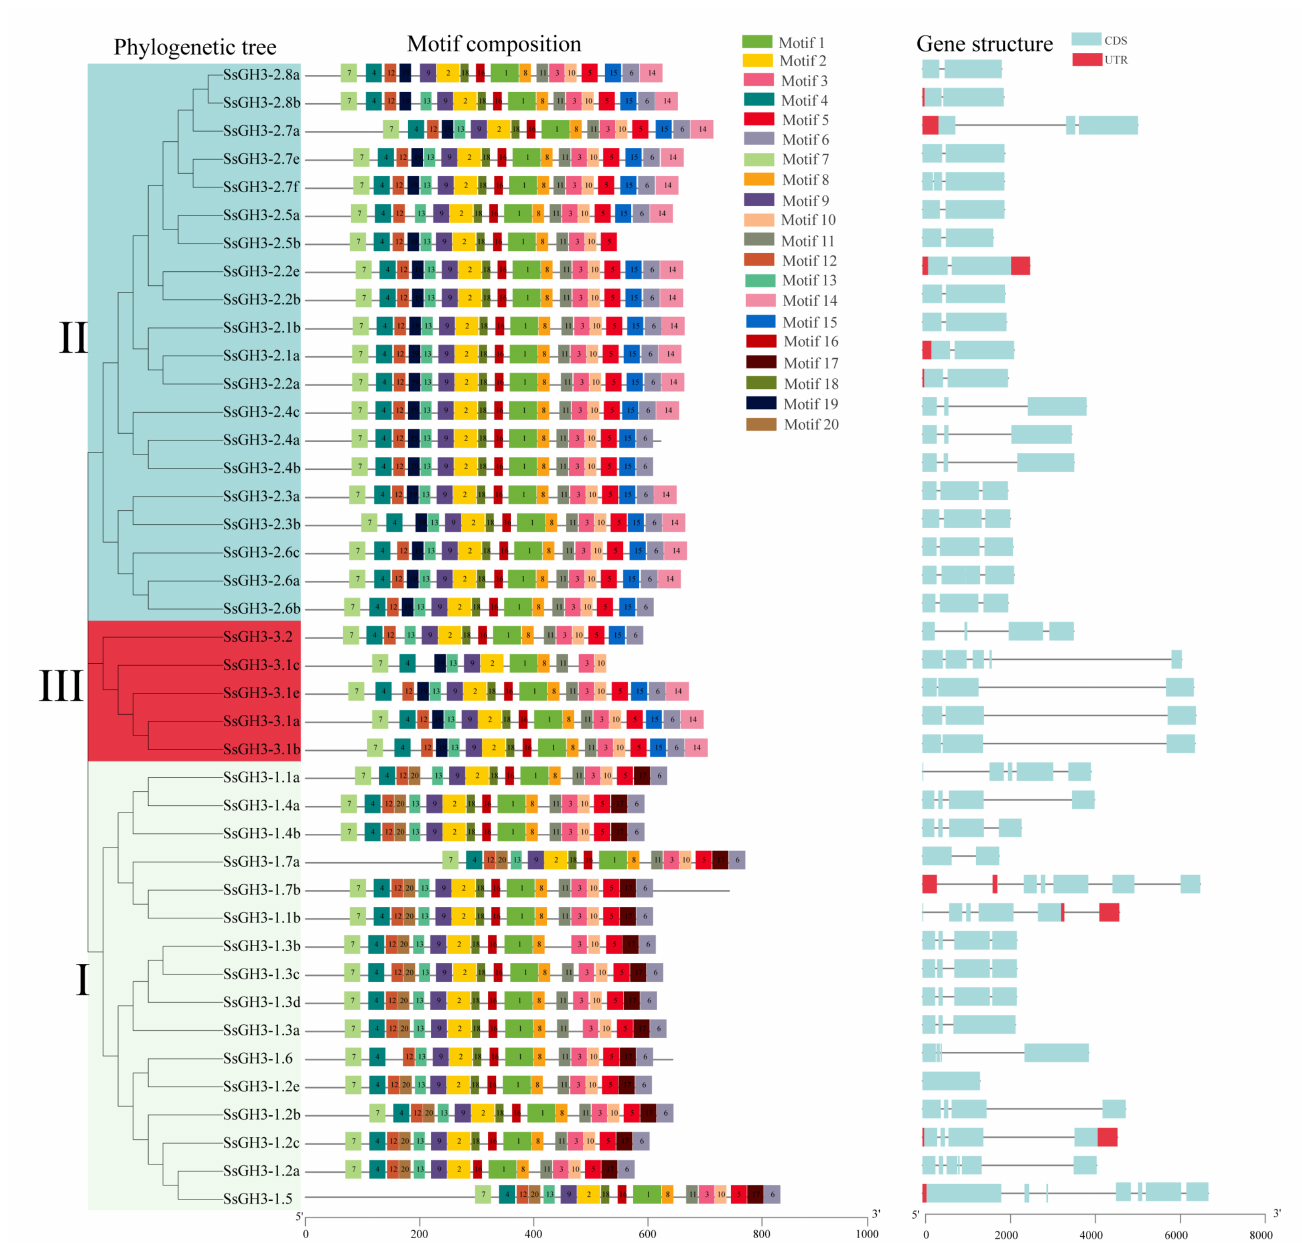
Figure 2. Phylogenetic tree, conserved motifs, and gene structure of the SsGH3 gene family. Different colors and Latin numbers (I, II and III) on the phylogenetic tree represent three subgroups of the SsGH3 genes. In the motif pattern, the 20 conserved motifs are displayed in different colored boxes. In exon-intron analysis, the grey line represents introns, the blue box represents the coding sequence, and the red box represents the non-coding sequence. I, II and III represented different